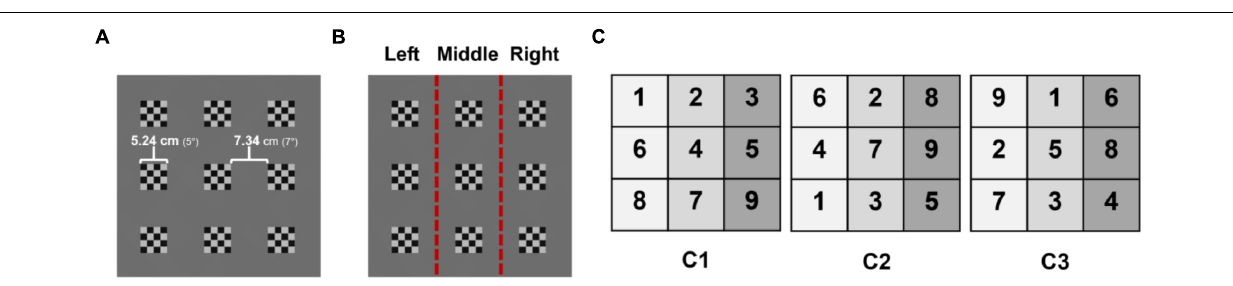
FIGURE 4 | (A) Nine visual stimuli presented on the screen, (B) the three directions classified using EOG: left, middle, and right, (C) three different configurations of pattern-reversing frequencies. Numbers represent the stimulus numbers listed in Table 1 . C1, C2, and C3 represent the three configurations of visual stimuli tested in the